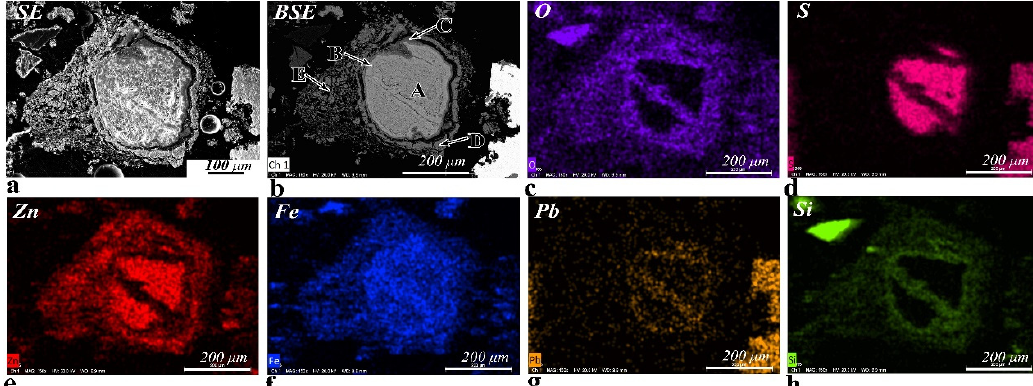
Figure 3. X-ray maps showing the distributions of O, S, Zn, Fe, Pb, and Si in a partially reacted sphalerite particle. ( a ) The secondary electron (SE) image shows the morphology of the grain; ( b ) Different grey levels in the backscattered electron (BSE) image imply different compositions. A– lightly reacted sphalerite (core), B– Fe-Pb-Zn-Si-O phase (brighter rim), C– Fe-Zn-Si-O phase (dark grey rim), D– a mixture of ZnFe 2 O 4 and Zn 2 SiO 4 (grey rim), E– a mixture of ZnFe 2 O 4 and Zn 2 SiO 4 (porous portion); ( c ) O K α map; ( d ) S K α map; ( e ) Zn K α map; ( f ) Fe K α map; ( g ) Pb L α map; and ( h ) Si K α map.